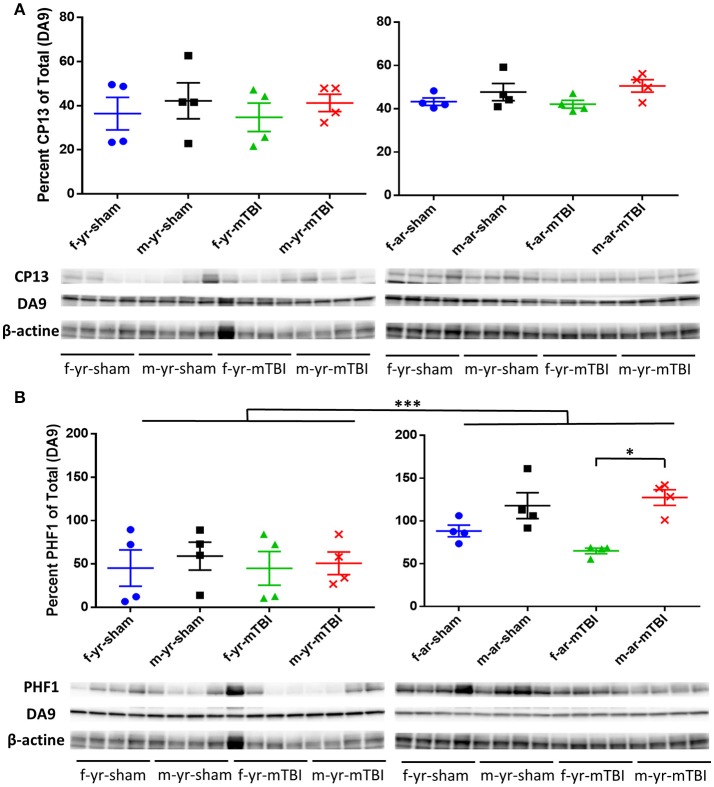
Immunoblots of cortical brain extracts of mice probed with monoclonal antibody CP-13 (pS202/pT205), PHF1, (pS396/404) or β-actine at 15 days post-injury in young (left panels) or aged animals (right panels). For the CP13 data (A), there were no difference observed between gender, age, or treatment (*, p > 0.05). For the PHF1 data (B), the average percent of PHF1 for the young mice was lower compared to aged mice averaged over gender and treatment (p < 0.0001) as well as within female mice (averaged over treatment, p = 0.0362), within male mice (averaged over treatment, p < 0.0001), within the mTBI treatment group (averaged over gender, p = 0.0024), and within the sham treatment group (averaged over gender, p = 0.0015). Additionally, the average percent of PHF1 among female mice was lower compared to the male mice averaged within the mTBI treatment (averaged over age, p = 0.0244). All densitometry values for CP13, PHF1, DA9 for individual bands were normalized to the beta actin (β-actin) value for their respective lane and this ratio used for statistical analysis. The primary outcomes in the Western Blot analysis were the percent of CP13 and PHF1 antibodies relative to the total (DA9). N = 4 (injured/sham). *p < 0.05; ***p < 0.0001.